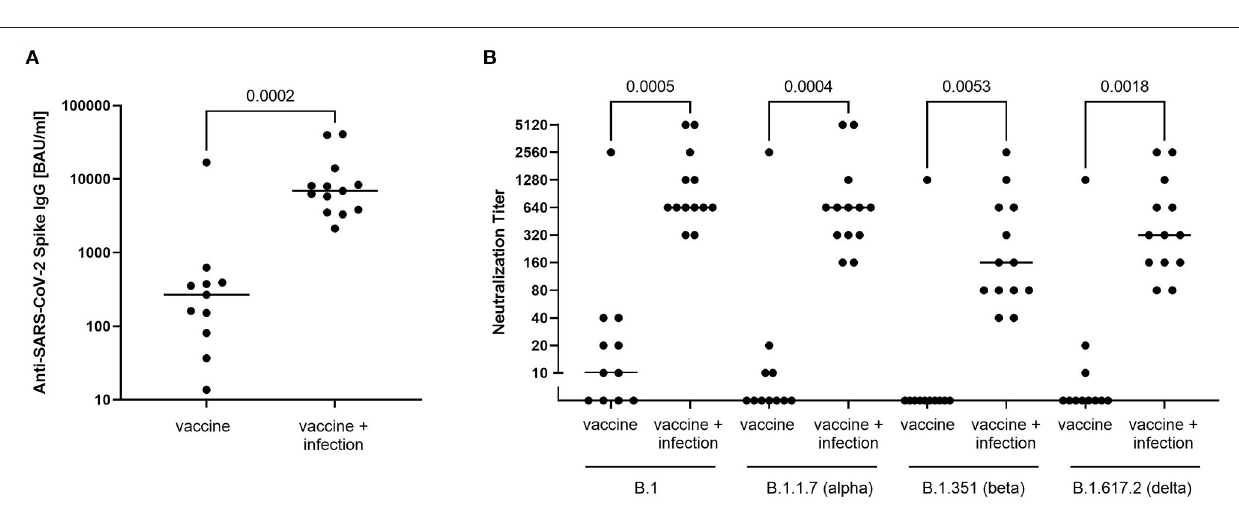
11 alpha variant, 10 of 11 beta variant, 8 of 11 delta variant), consistent with immune escape of the beta variant. Notably, although there was also evidence for decreased neutralisation